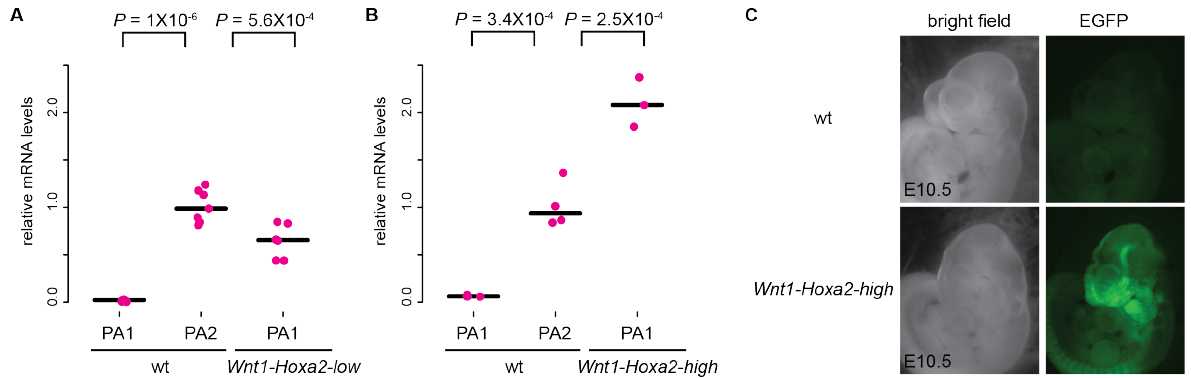
Figure 1. Ectopic Hoxa2 expression in Wnt1-Hoxa2-low and Wnt1-Hoxa2-high mouse embryos. ( A , B ) Quantification of ectopic Hoxa2 mRNA expression levels in E10.5 Wnt1-Hoxa2-low ( A ) and Wnt1- Hoxa2-high ( B ) embryos by RT-qPCR. Hoxa2 mRNA levels were quantified in PA2 and PA1 of wild-